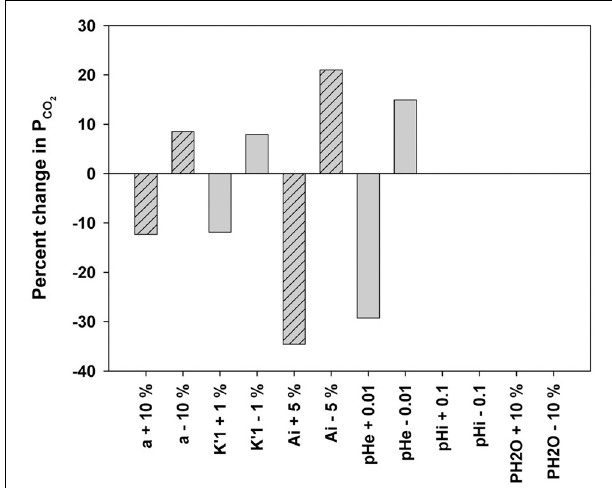
FIGURE 13 | Sensitivity of the estimated P CO for variations in the 2 parameters used in the system of equations decribing the processes of Figure 8. a, Surface-to-volume ratio of cells; K (cid:5) 1 , first apparent disscociation constant of carbonic acid: K (cid:5) 1 = [H + ] [HCO − 3 ]/[CO 2 ]; Ai, intracellular CA activity; pHe, extracellular pH in measuring chamber; pHi, , water permeability of cell membrane. Reproduced intracellular pH; P H 2 0 from Endeward et al. (2008), with